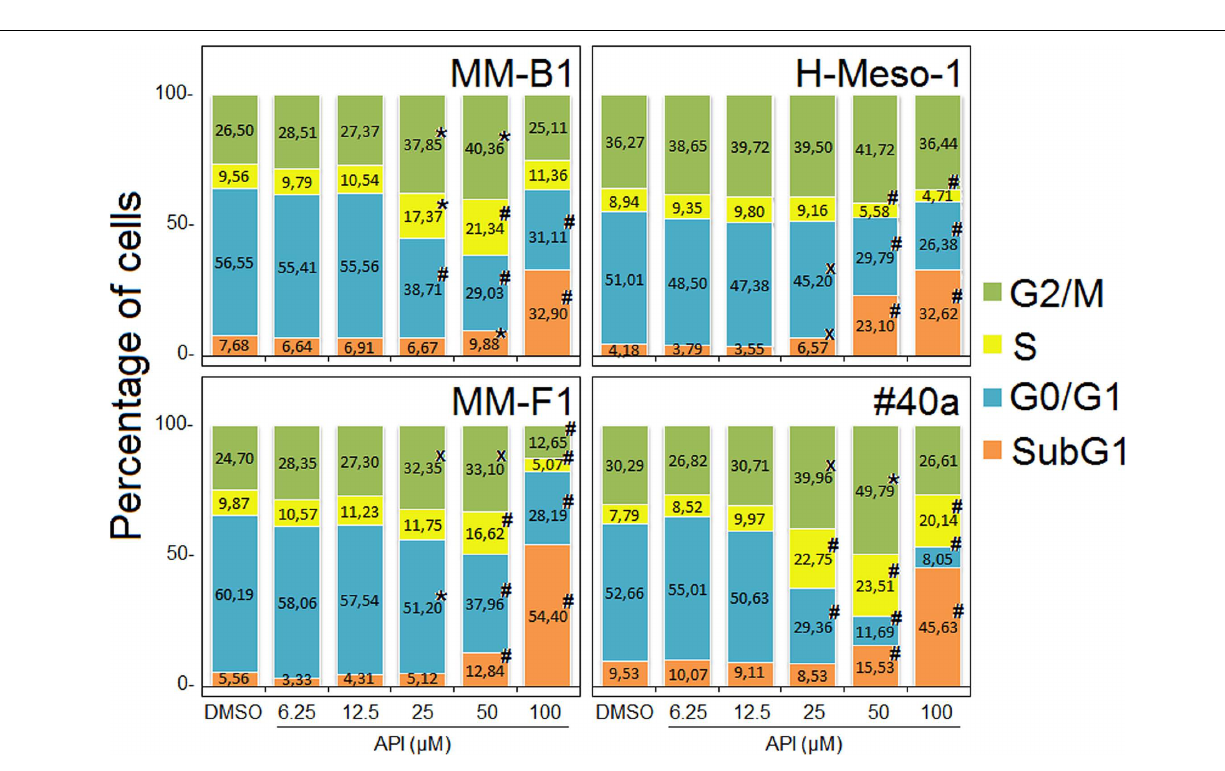
Frontiers in Pharmacology |